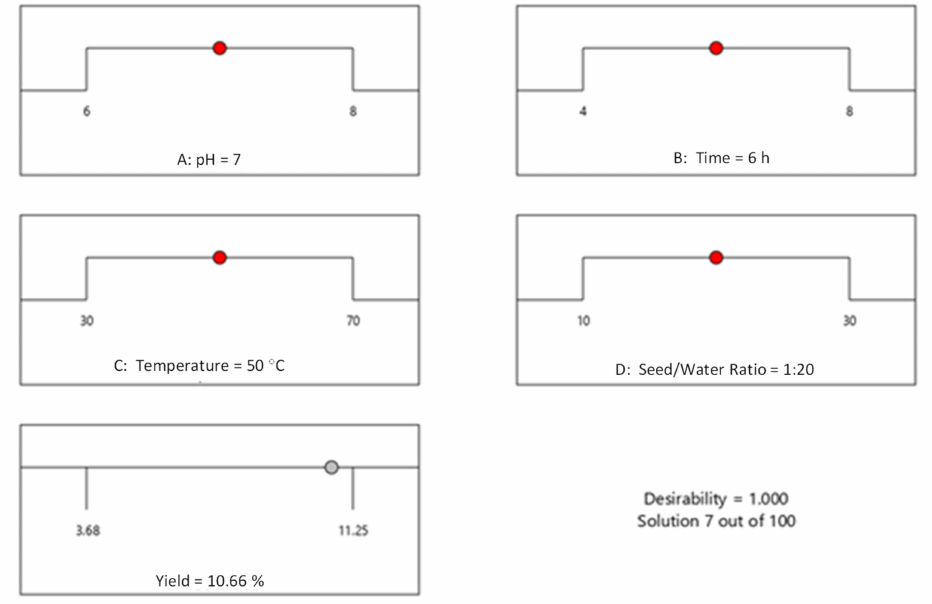
Figure 5. Desirability plot for the extraction optimization of MPM from MP